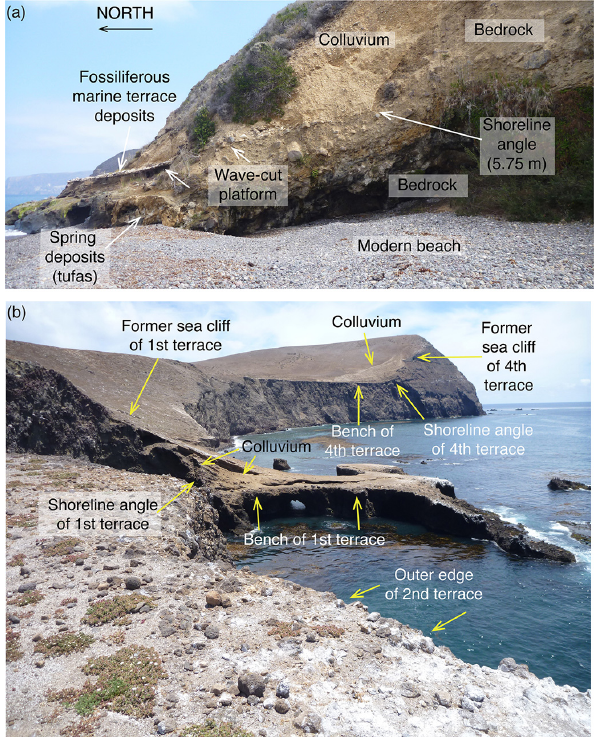
Figure 5. Examples of exposures of ancient shoreline angles: (a) north coast of Santa Cruz Island, California, just east of Pris- oners Harbor; (b) west side of Santa Barbara Island, California, showing benches and shoreline angles of three of the four lowest marine terraces. Photographs by Daniel R.